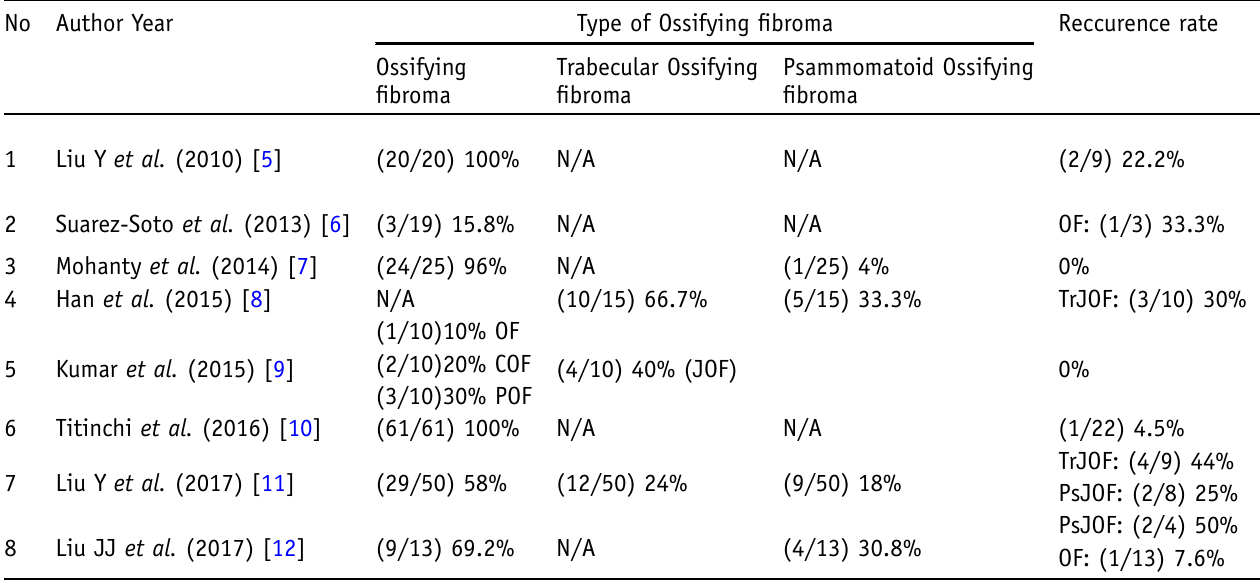
Table IV. Recurrence rate based on ossifying fi broma